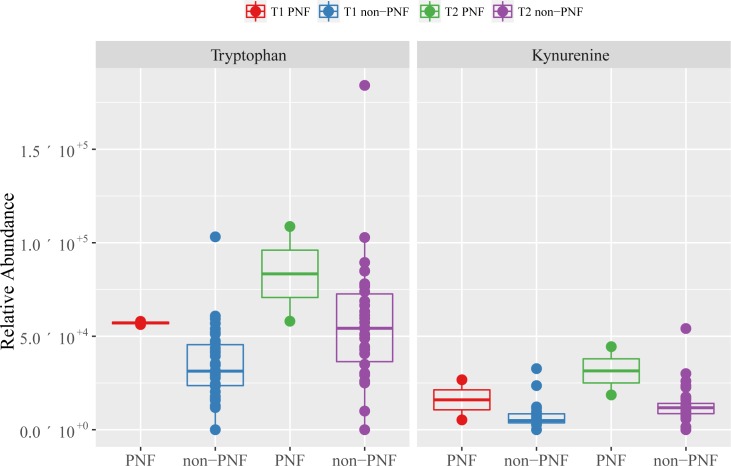
The differences between tryptophan and kynurenine in failed allografts due to Primary non-function/PNF (n = 2) vs. non-PNF (n = 36) in the cold phase and post reperfusion.The data show the relative abundances of the metabolites with 95% confidence intervals (statistics not applied due to limited sample size).